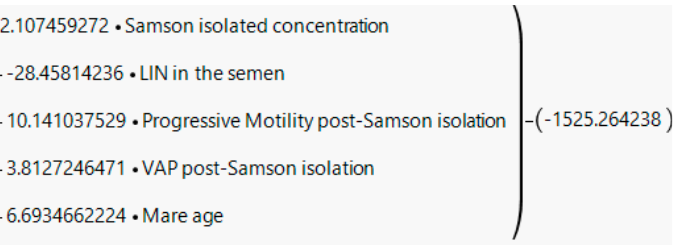
Figure A4. Equation optimized for stallion 3 from the pre-chilled data set: predictive accuracy of 100%.